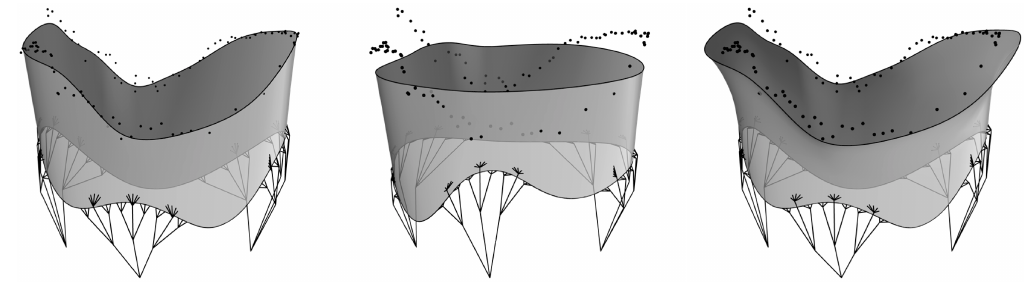
Figure 16. TV geometries of healthy, flattened, and dilated valves.